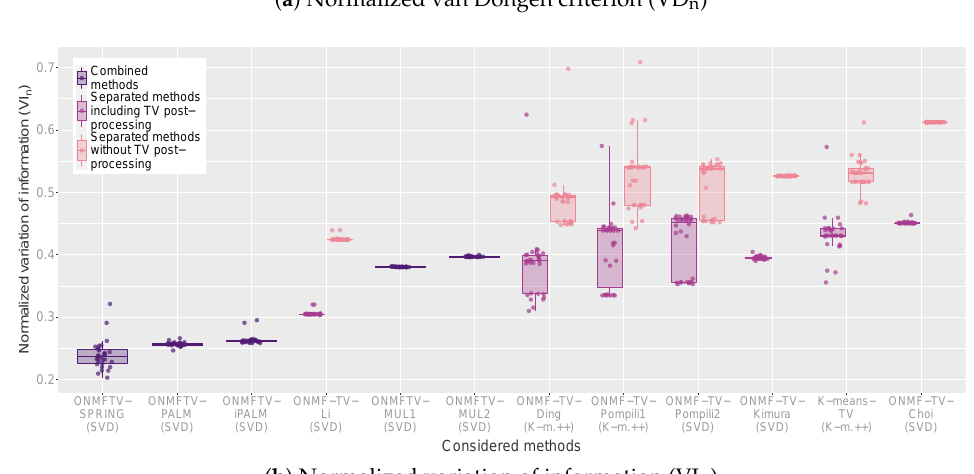
( a ) Normalized van Dongen criterion (VD n )